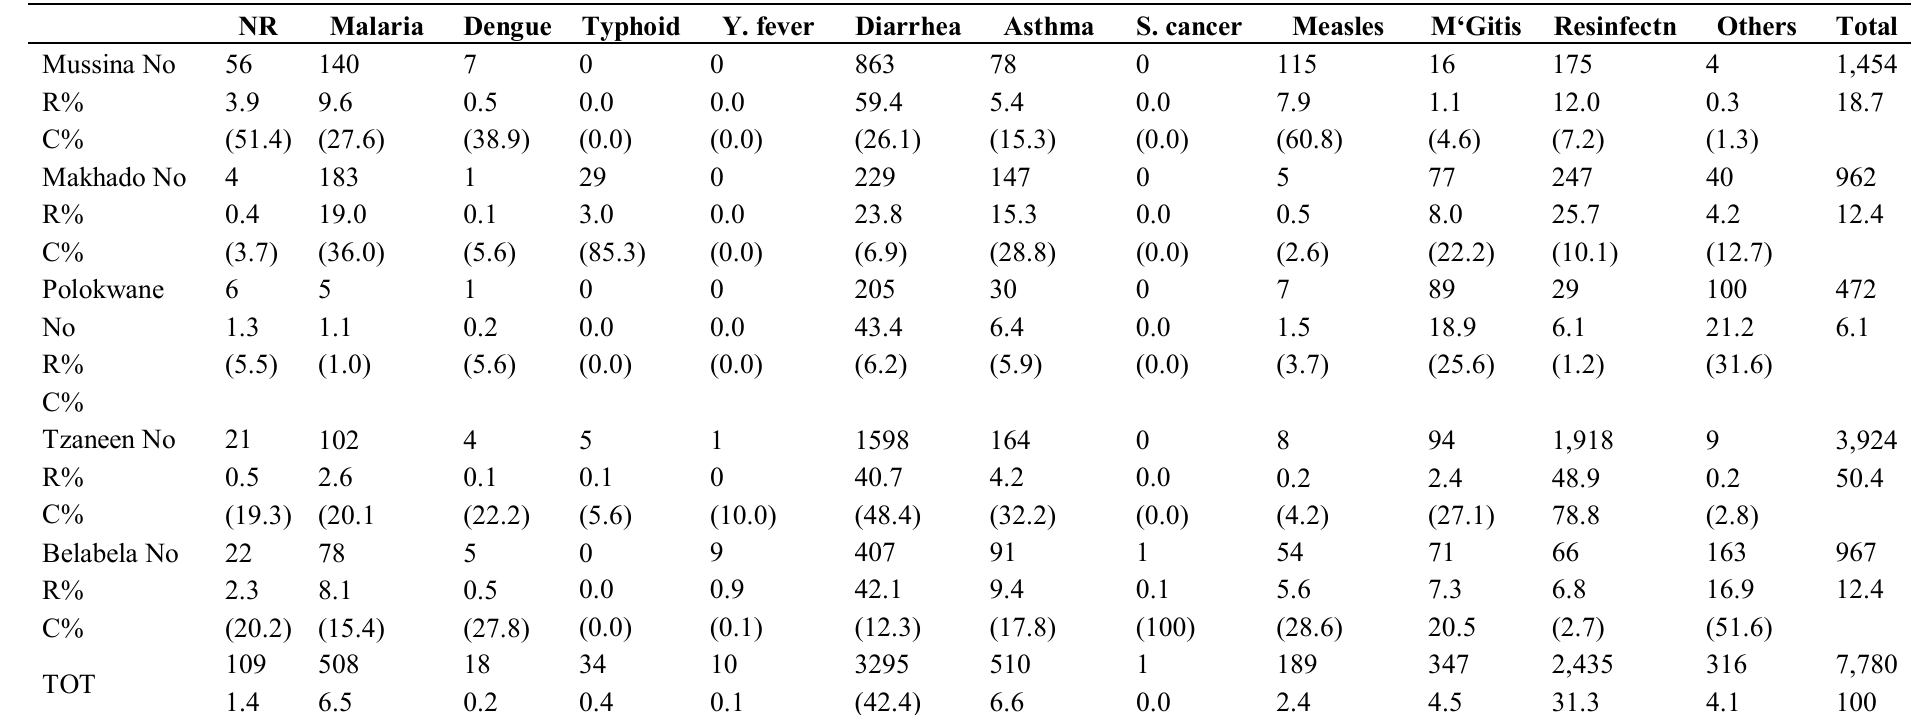
Table 1. City variations in incidence of